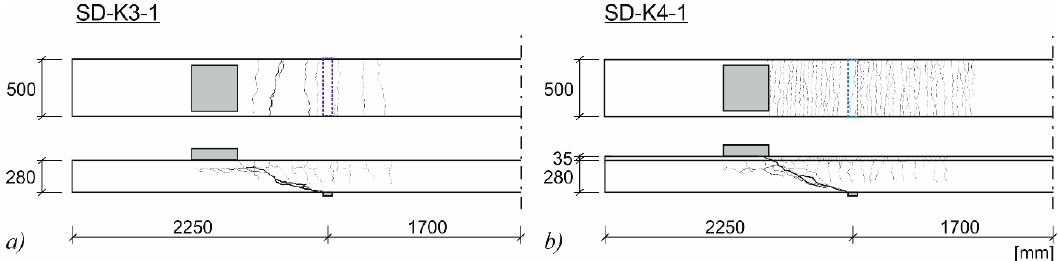
Figure 5. Crack pattern of ( a ) SD-K3-1; and ( b ) SD-K4-1.